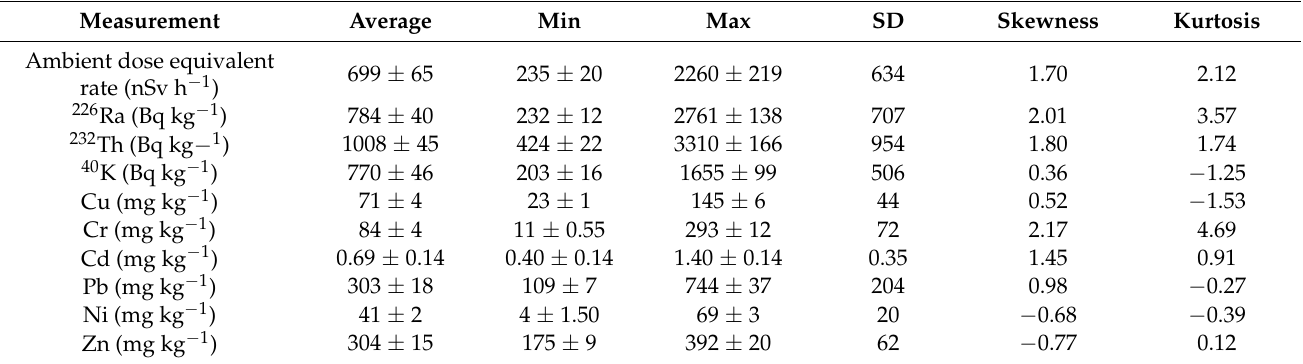
Table 1. The descriptive statistics of ambient dose equivalent rate, natural radionuclides, and heavy metals in a soil sample from